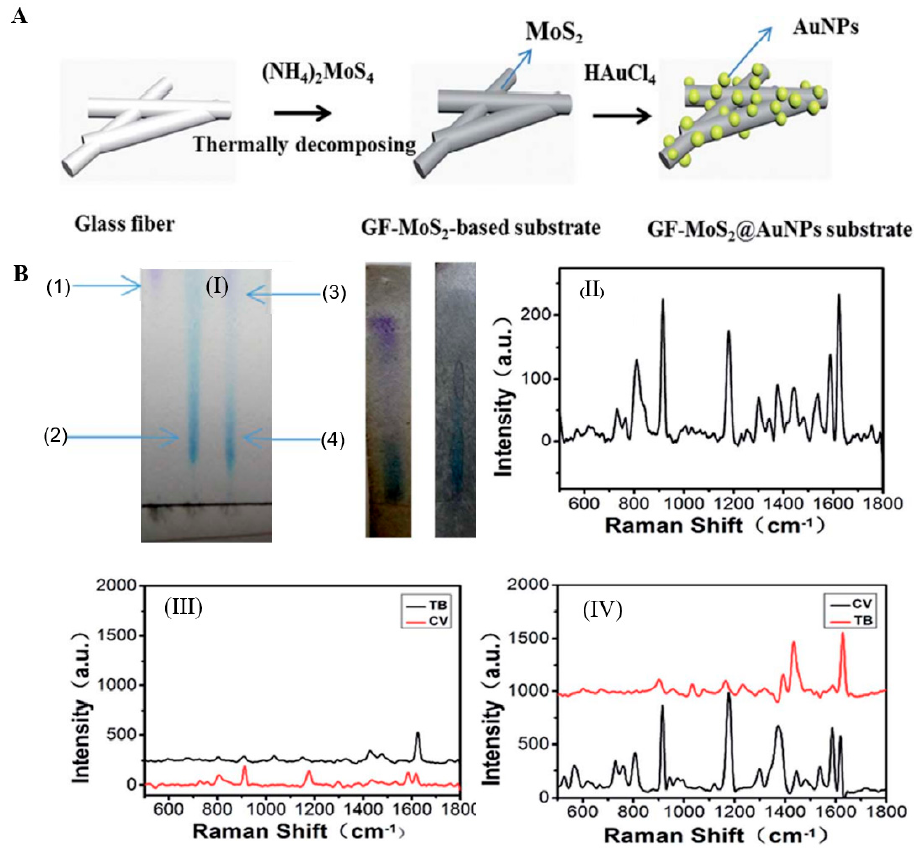
Figure 9. ( A ) Schematic of the synthesis of the GF − MoS 2 @AuNP substrate. ( B ) ( I ) Colorimetric detection of dye molecules (CV, TB, and their mixed solution) after paper separation and images of the mixed solution after separation on the MoS 2 and GF-MoS 2 @AuNP − 4 substrates. ( II ) Raman spectra of the mixed solution. Sub − figures ( III ) and ( IV ) are Raman spectra of the CV and TB molecules after paper separation on the MoS 2 and GF − MoS 2 @AuNPs substrates. Reproduced with permission from reference [71]. Copyright 2017 RSC Advances .